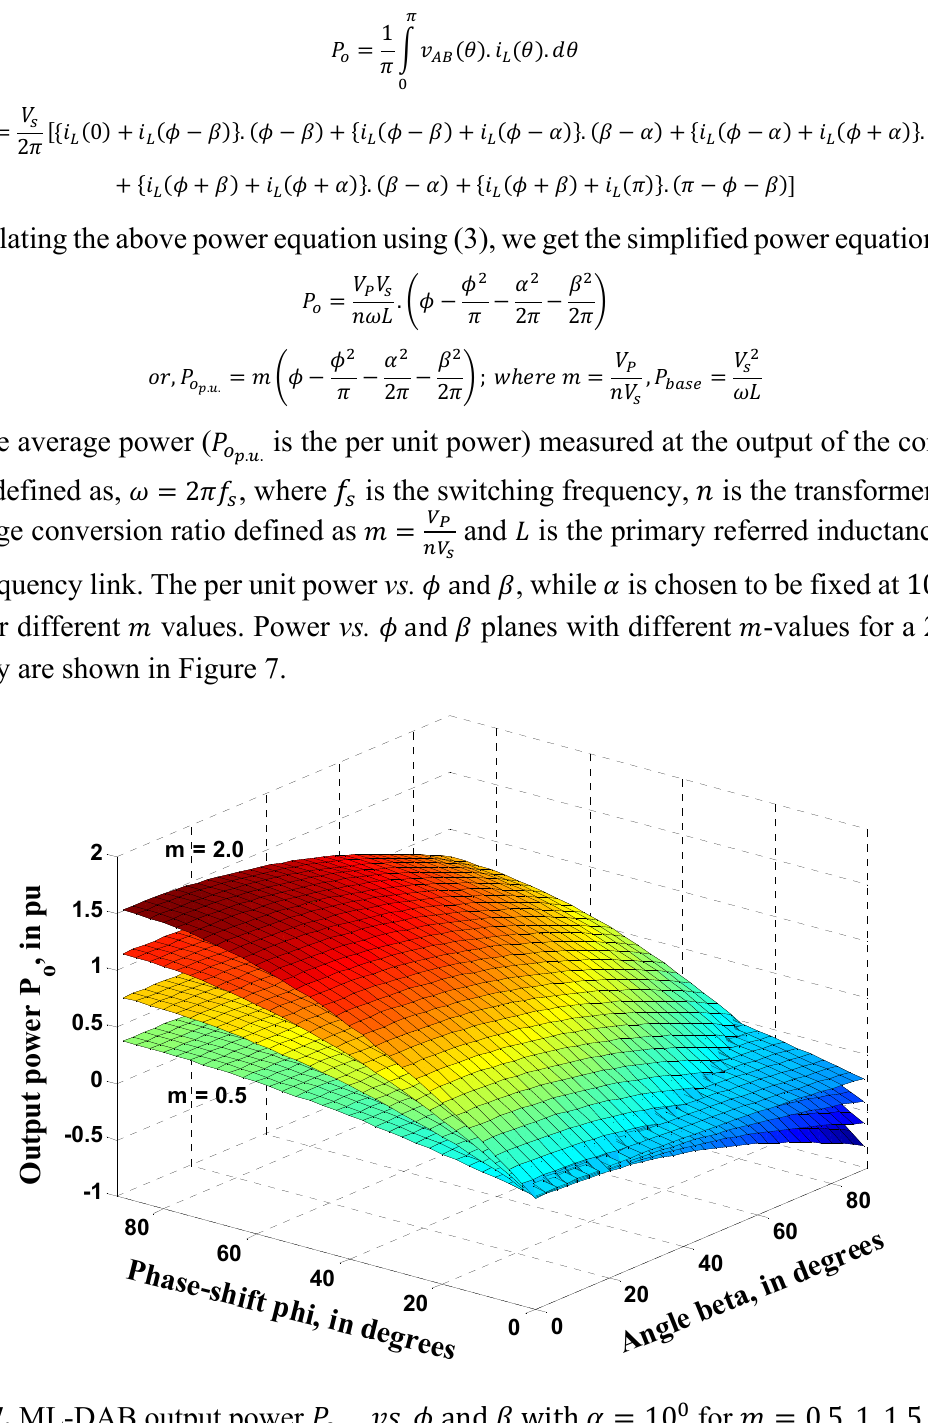
Figure 7. ML-DAB output power (cid:1842)